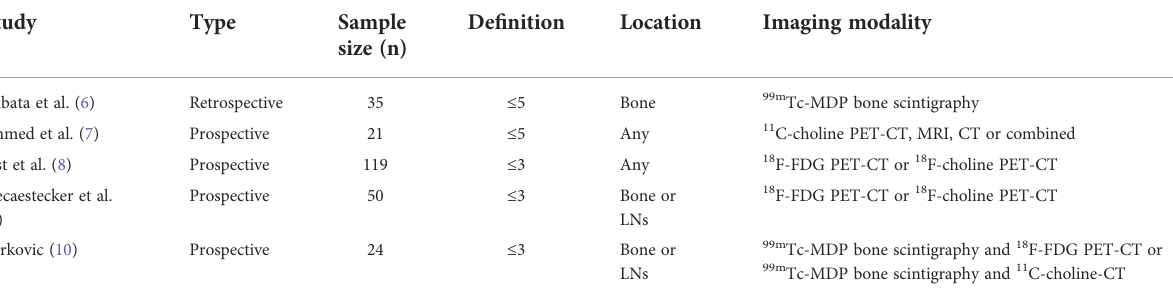
TABLE 1 Representative historical de fi nition of oligometastatic disease in